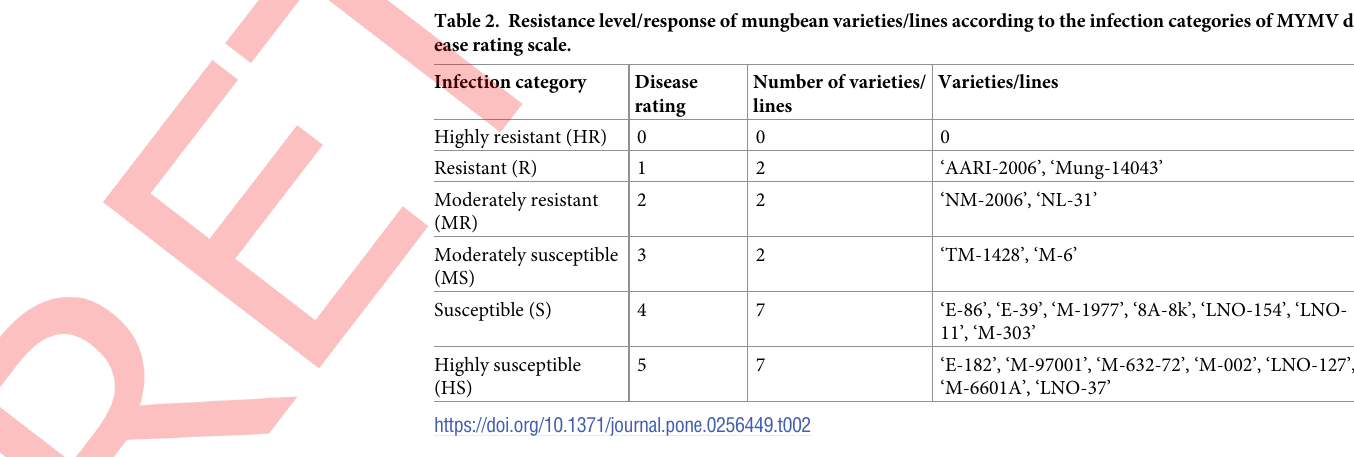
Table 2. Resistance level/response of mungbean varieties/lines according to the infection categories of MYMV dis- ease rating